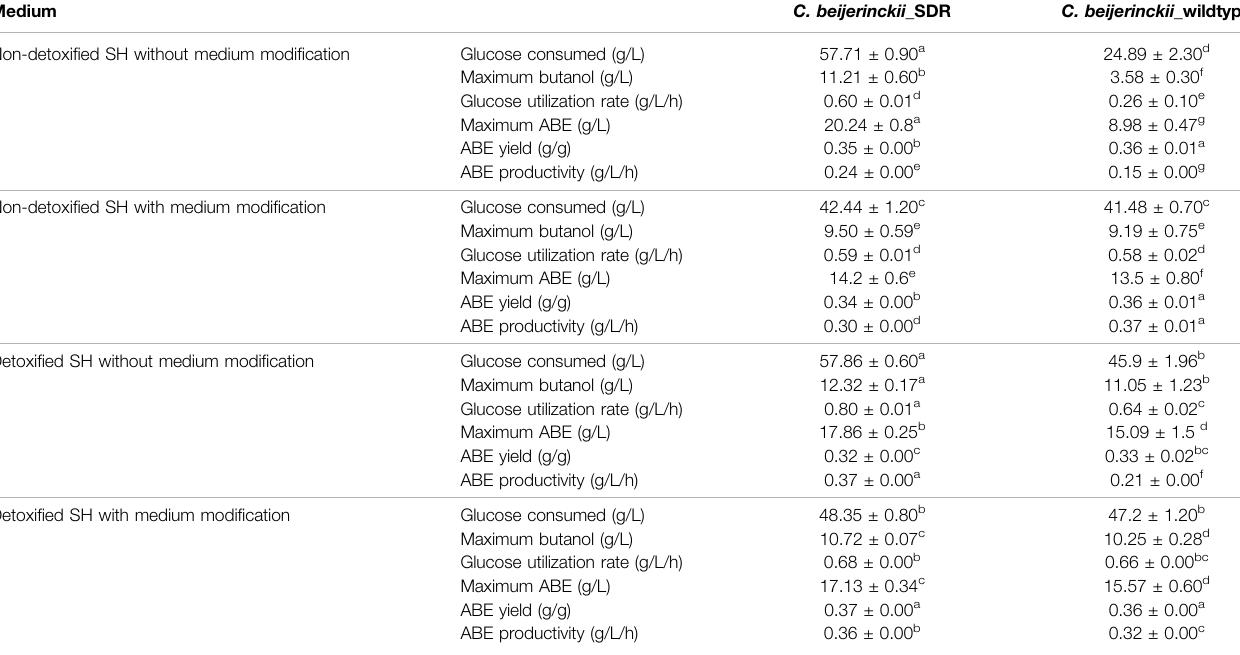
TABLE 3 | Summary of data from the fermentation of SH by C. beijerinckii _SDR and C. beijerinckii _wildtype. Standard deviation for readings represents triplicate ( n = 3)*.